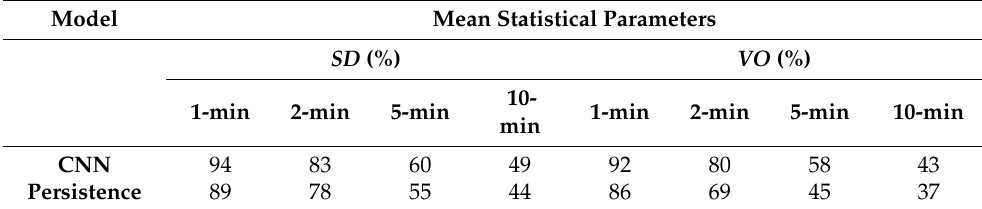
Table 2. Comparison between the statistical indicators of the proposed CNN model and the per- sistence model: the mean Sørensen–Dice similarity coefficient ( SD) and overlap ( VO) of the 5000 simulated cases for 1-, 2-, 5-, and 10-min forecasts.